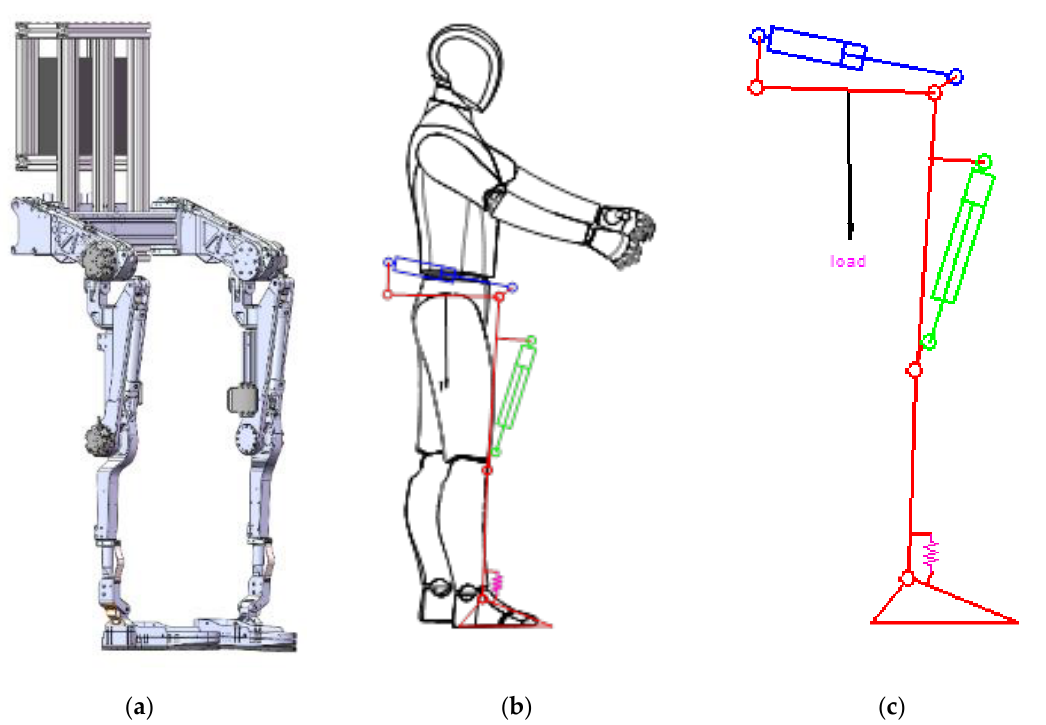
Figure 1. Mechanical structure of the exoskeleton. ( a ) Three-dimensional model. ( b ) Wearing the schematic diagram. ( c ) Linkage structure.